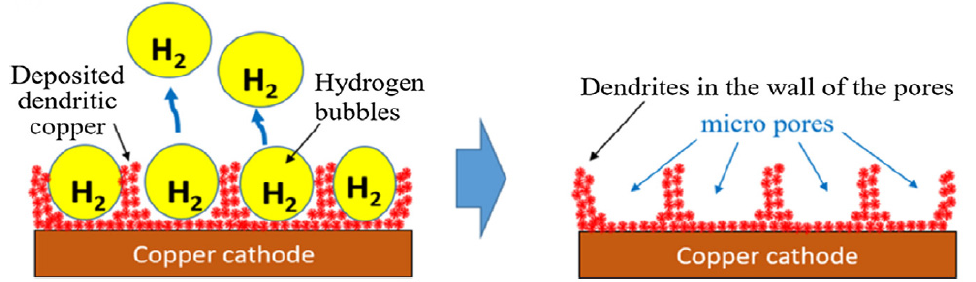
Figure 6. Schematic illustration of a micro-nano bi-porous copper surface with hydrogen bubbles departing the cathode using the dynamic bubble template electrodeposition method [90].